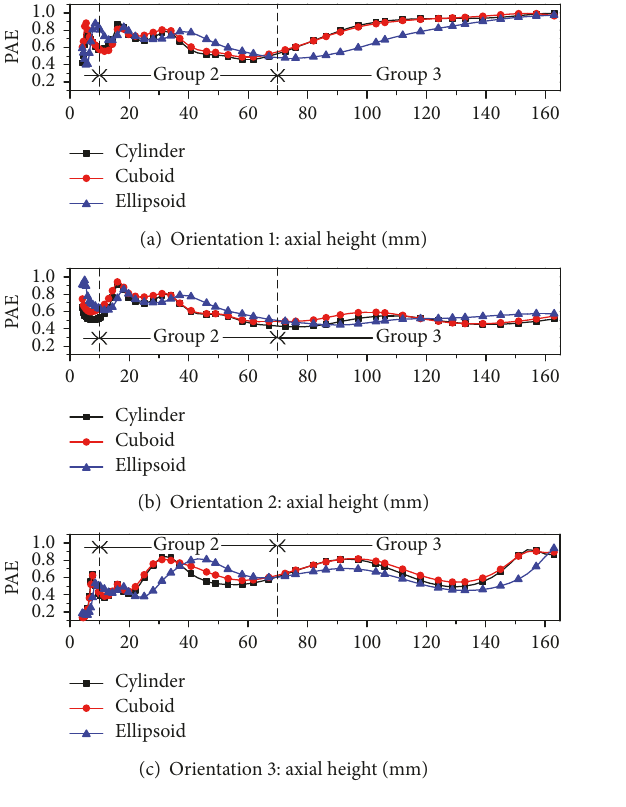
Figure 23: PAE of different shapes. Figure 24: COV of different